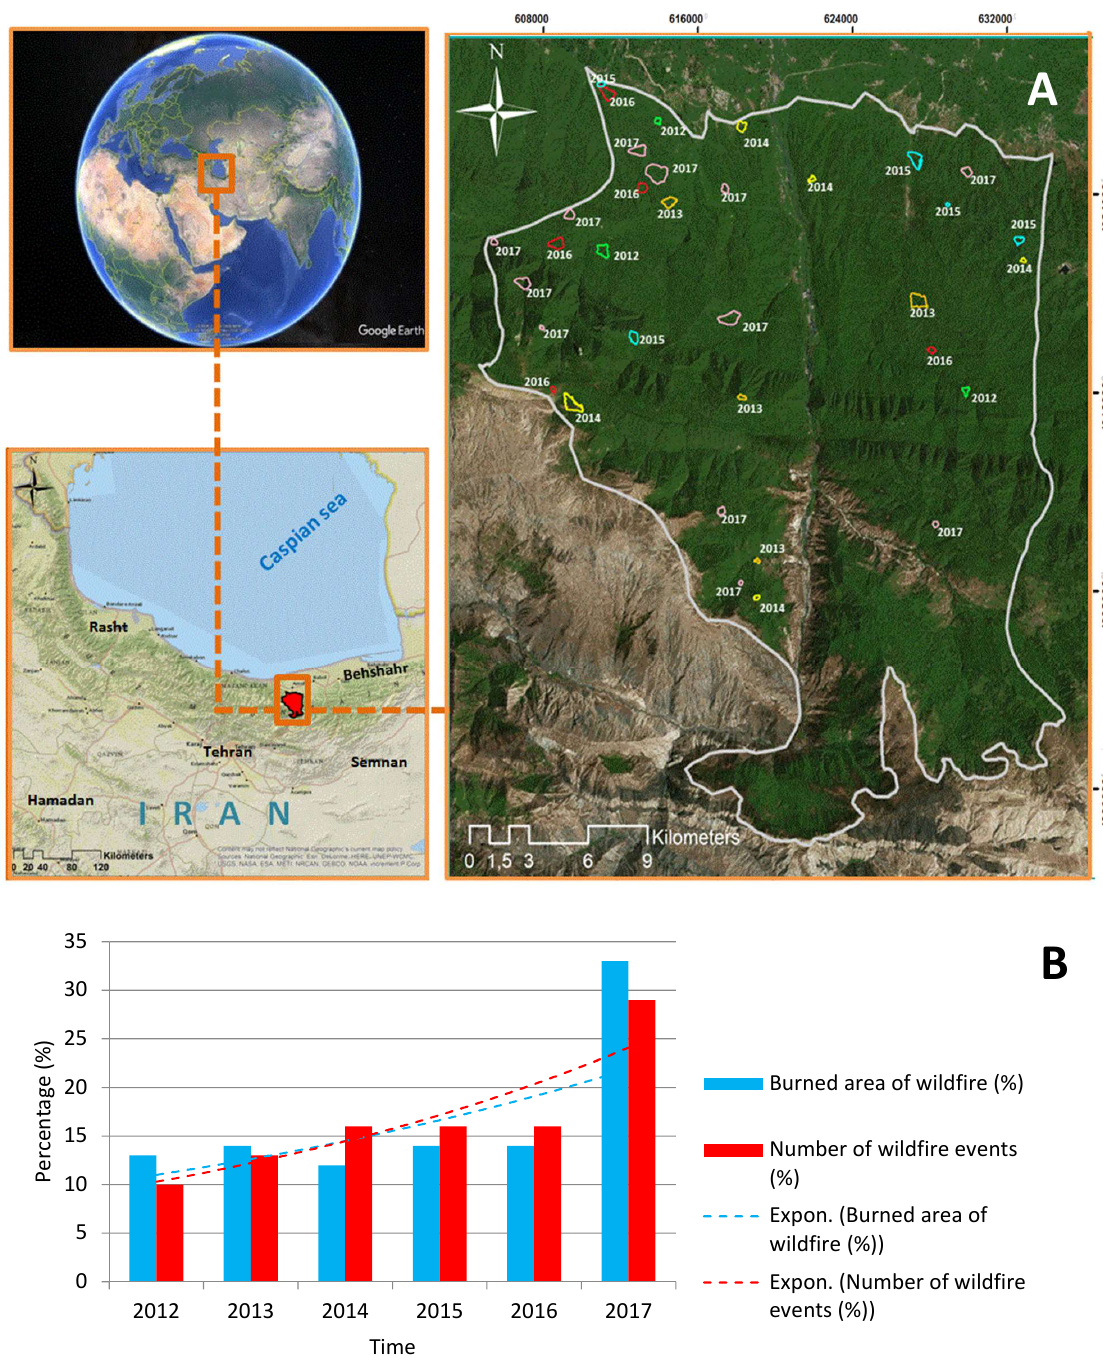
Figure 1. The location of the study area. ( A ) Polygons of the location of burned areas detected from moderate resolution imaging spectroradiometer (MODIS) enhanced using global positioning system (GPS) data collected from 2012 to 2017. ( B ) The percentage of the burned area and the number of wildfire events.